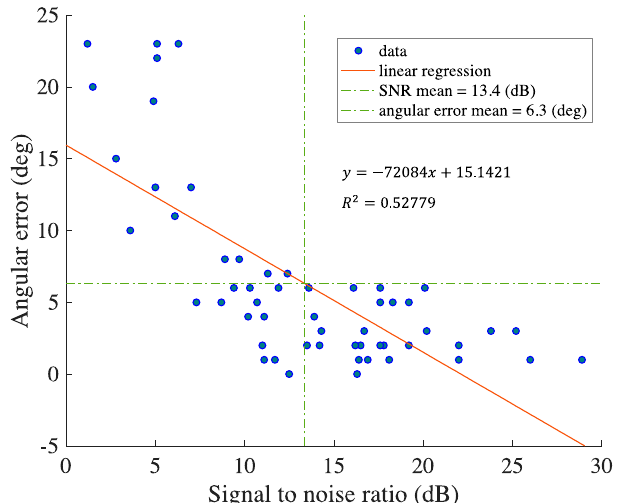
Figure 12. Scatter plot of the SNR and bearing error statistics of the sample vessels.